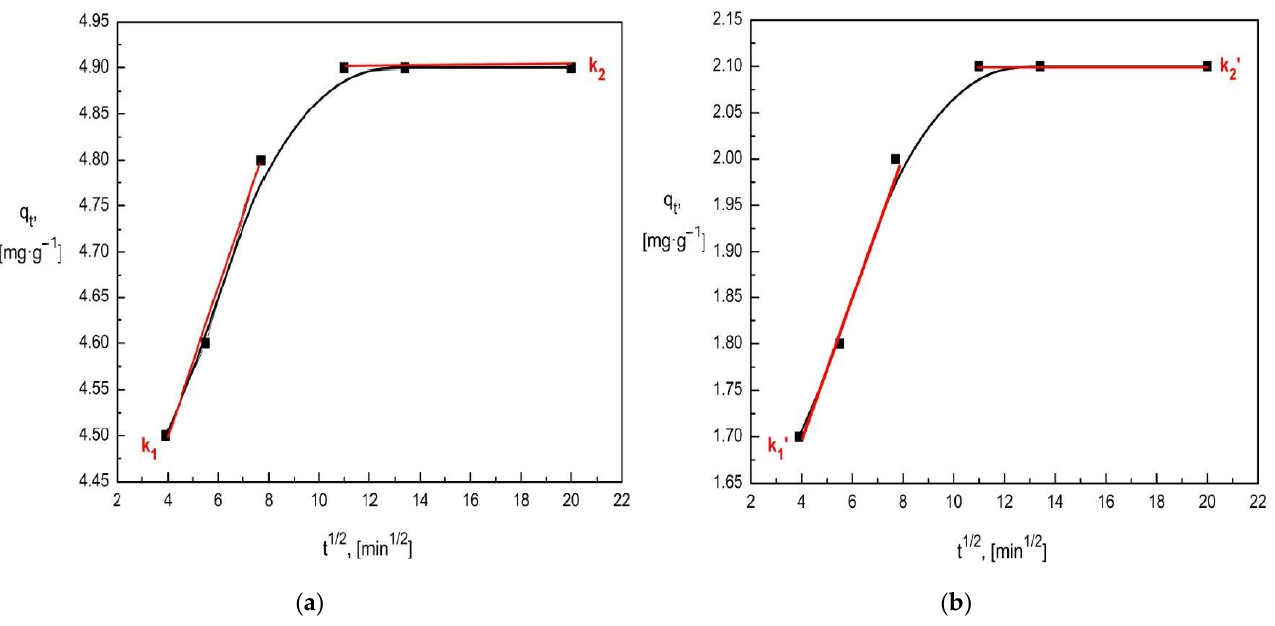
Figure 10. Intraparticle diffusion model in the diatomite adsorption process: ( a ) chromates ions, ( b ) phosphates ions. Table 10. Values of the diffusion rate constants of the phosphates and chromates adsorption process.